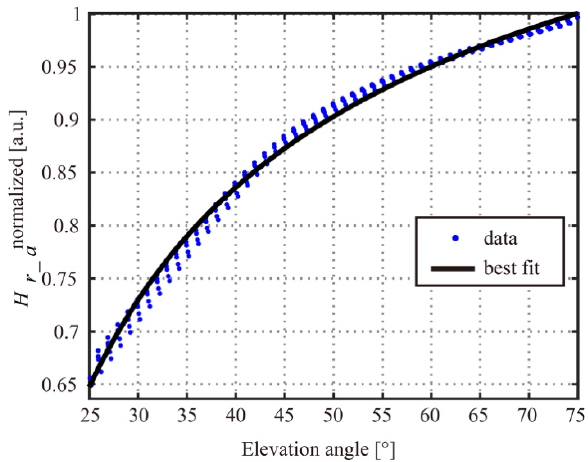
Figure 3. (blue) The normalized height retrieved from the Z-V model using the DER method for GPS L5 signal for different wind speeds versus elevation angle, with (black) superimposed best-fit power function. The coe ffi cients are a = − 3.769, b = − 0.5631, and c = 1.345.